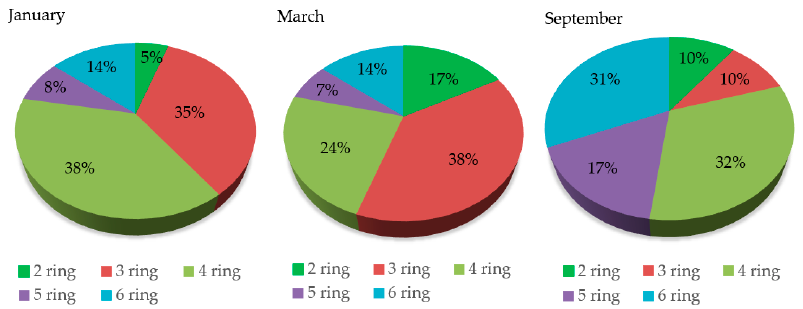
Figure 2. Atmospheric concentrations of PAHs in Ulaanbaatar City.